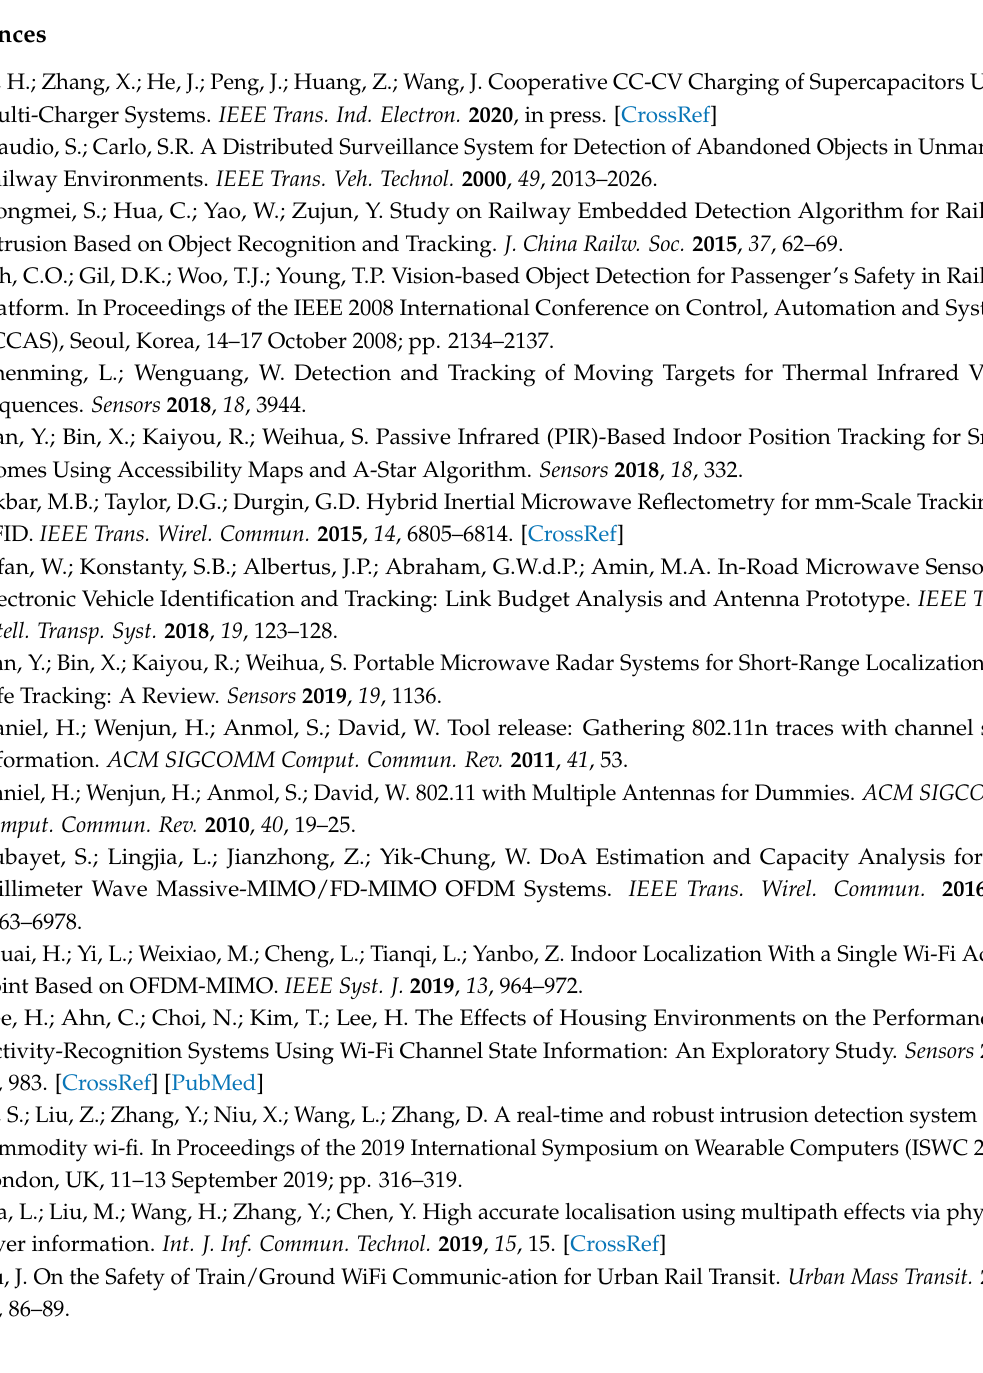
Figure A1. Construction of smoothed CSI